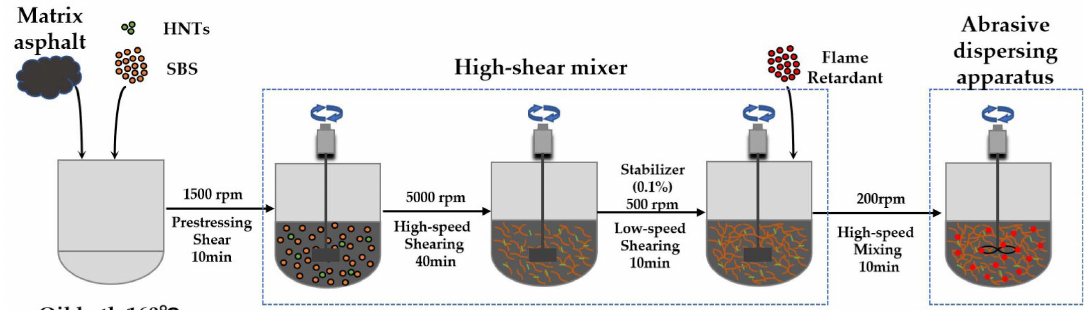
Figure 2. Preparation flow chart of flame-retardant-modified asphalt